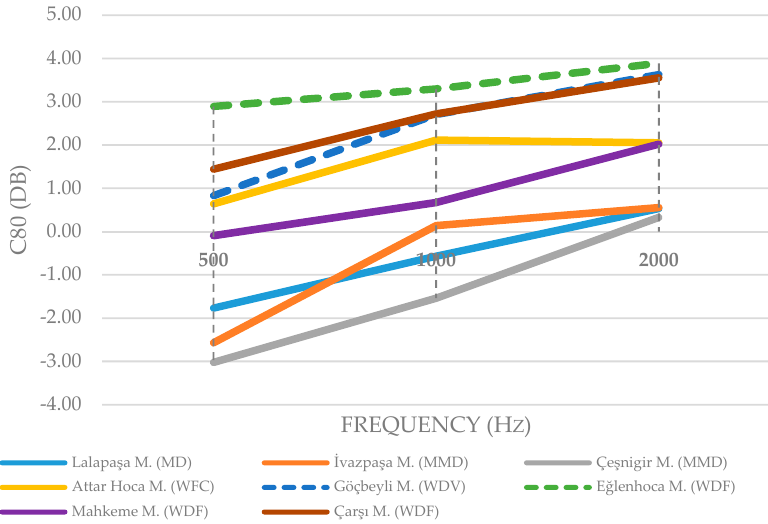
Figure 15. The average values of C80 measured in the eight mosques.